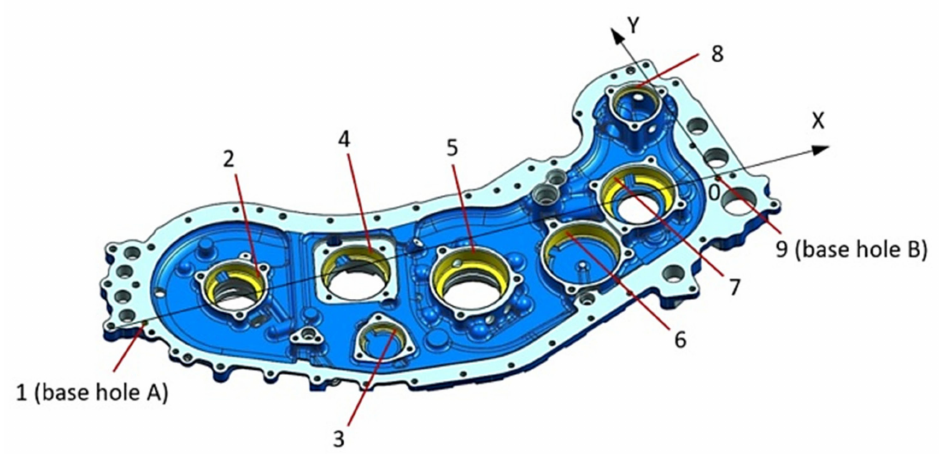
Figure 5. ADT casing cover model with bearing seats and base holes (yellow)